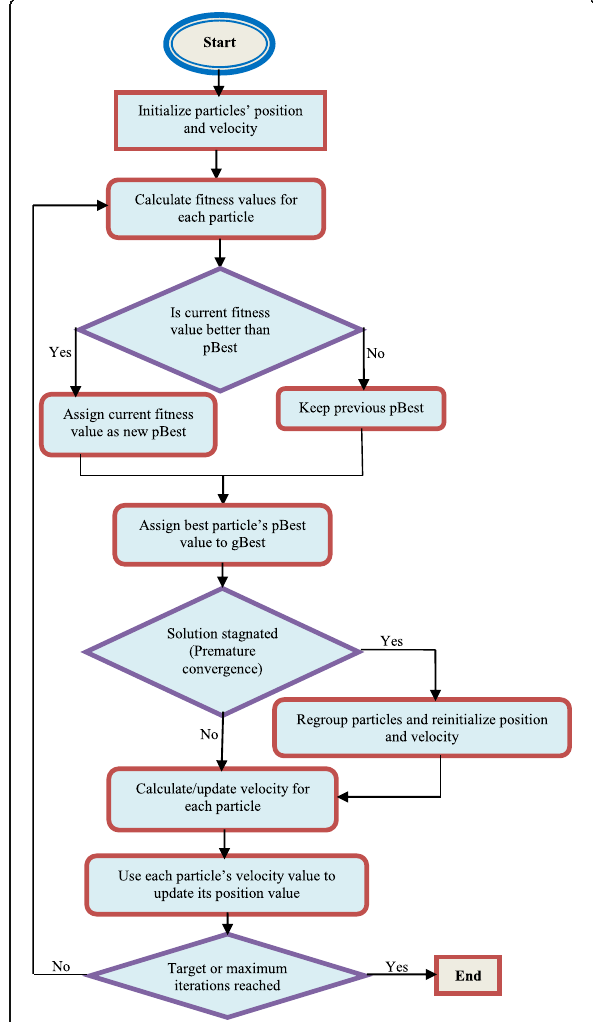
Fig. 3 Flowchart of the RegPSO